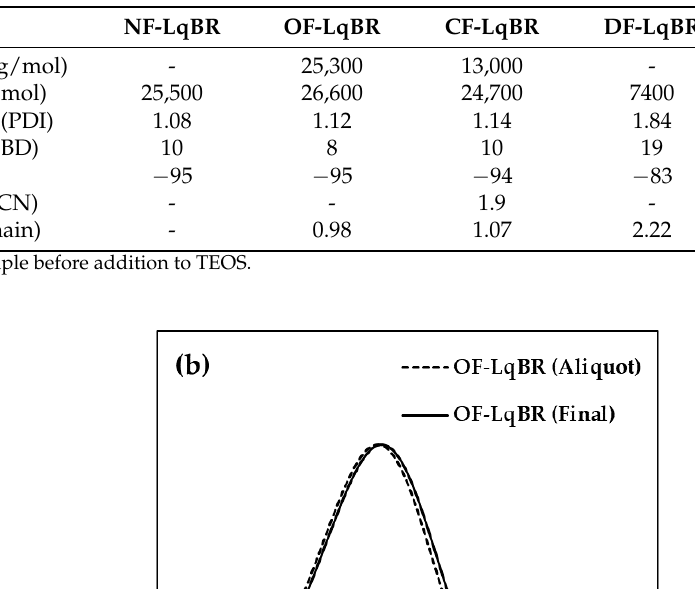
Table 4. Characteristics of LqBRs.